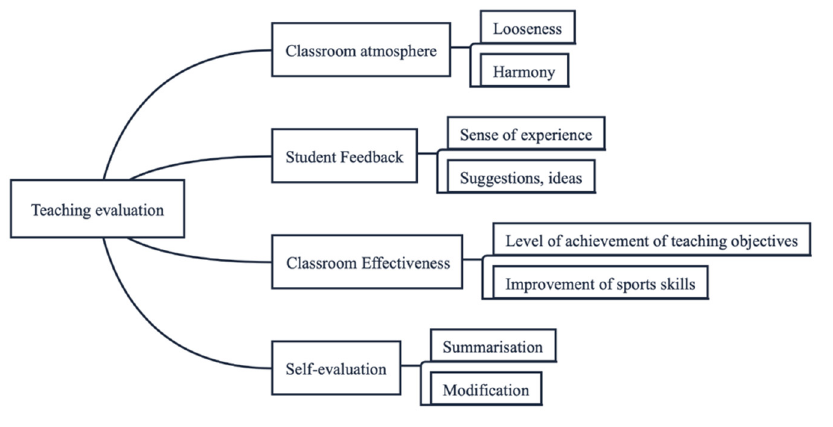
Figure 6. Figure of teaching evaluation.